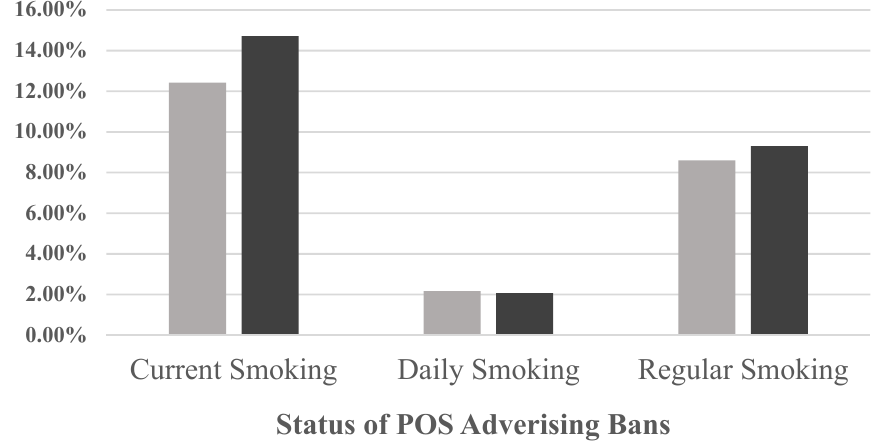
Figure 1. Current smoking, daily smoking, and regular smoking by POS advertising bans.